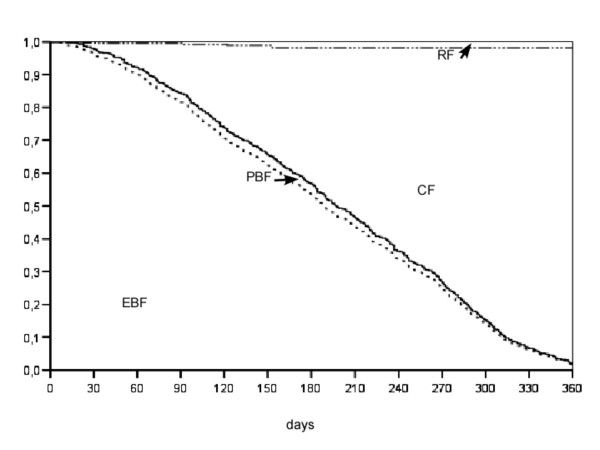
The proportion being exclusively breastfed (EBF), predominantly breastfed (PBF), complementary fed (CF) and replacement fed (RF) according to the 24-hour recall.